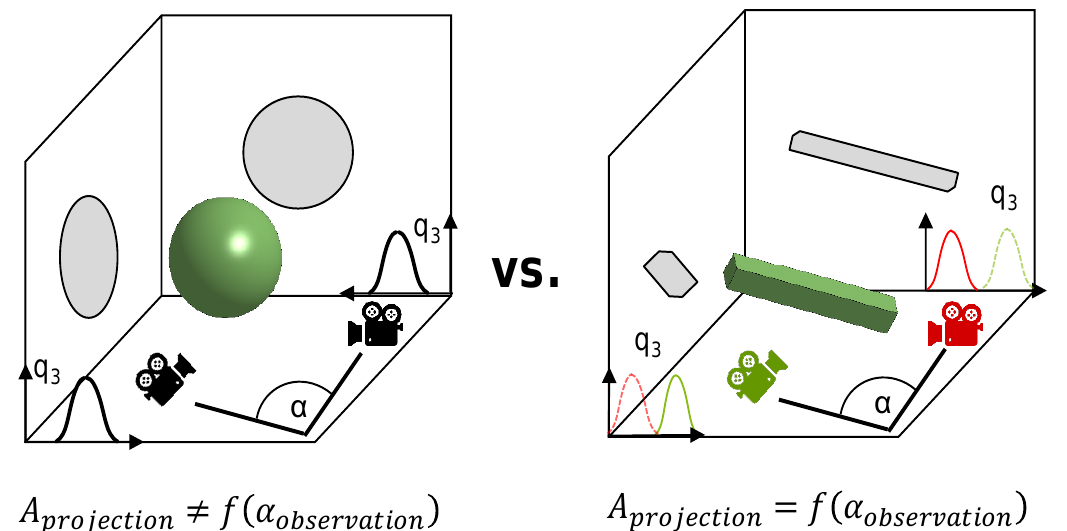
Figure 3. Challenges occurring with 2D-image analysis of non-spherical particles. The grey surfaces show the measured areas by dynamic image analysis for two different angles of α observation . The differences in the resulting PSDs are schematically shown in the left and right corners of the cubic analytical space.